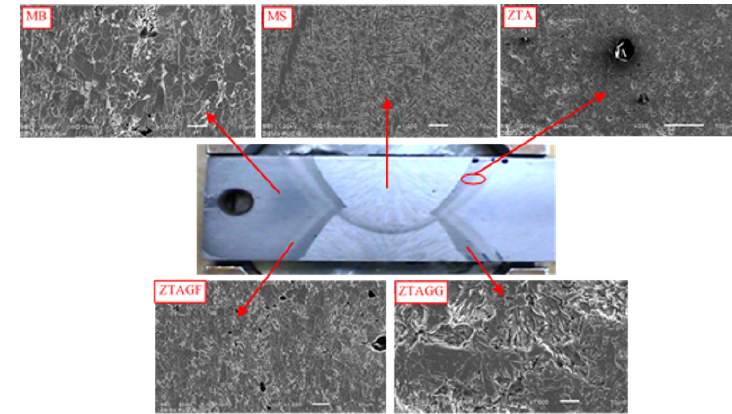
Figure 6. SEM surface characterization of a sample tested in brine (pH=3.0) after immersion for 30 days.